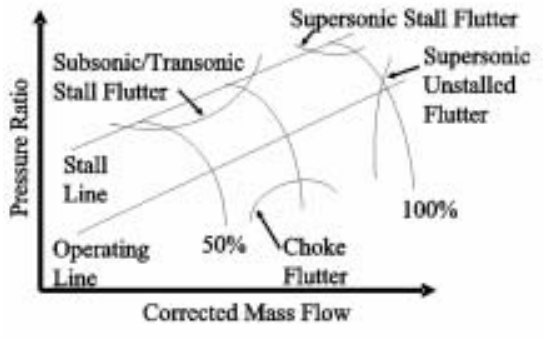
Fig. 1. Typical performance map of a fan or compressor showing the possible flutter